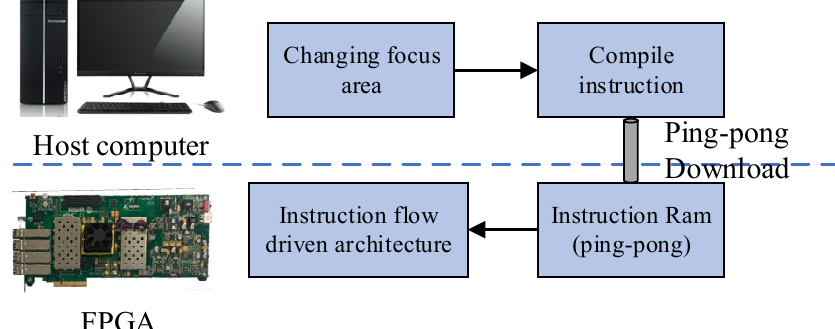
Figure 3. Instruction replacement process of instruction flow-driven architecture.